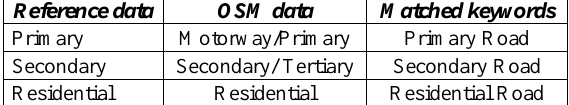
Table 1. Semantic matching between OSM and reference data